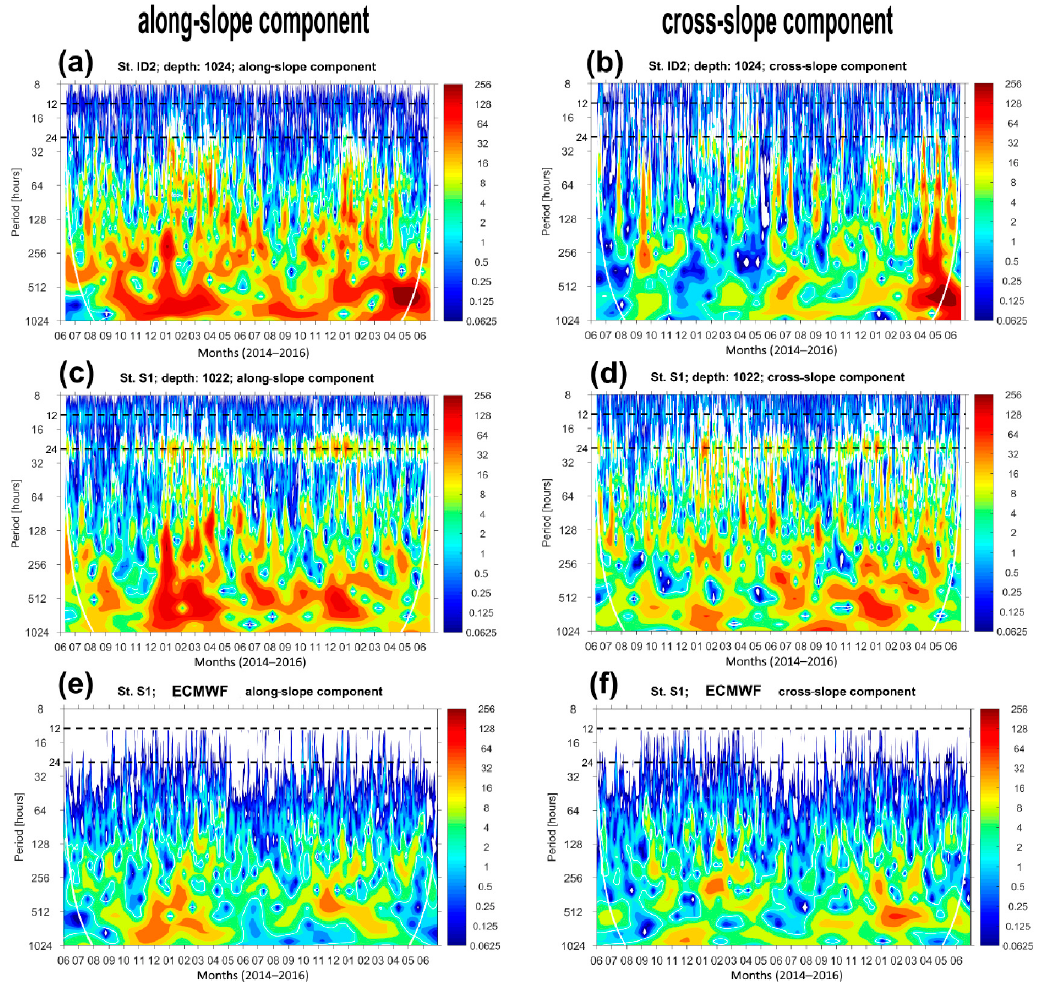
Figure 10. Wavelet power spectrum of the along-slope ( a , c , e ) and cross-slope ( b , d , f ) components (obtained from principal component analysis) of deep currents at ID2 and S1, and ECMWF wind data at S1 (not filtered). Periodicities of 12 and 24 h are indicated by black dashed lines.